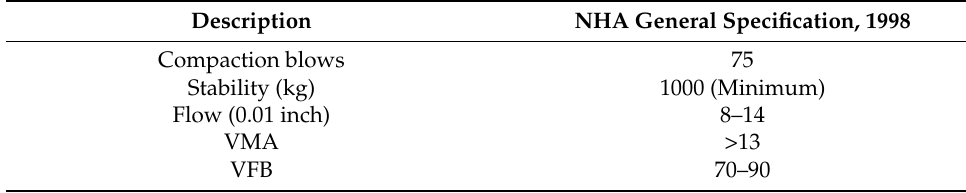
Table 6. NHA specifications for Marshall Parameters.